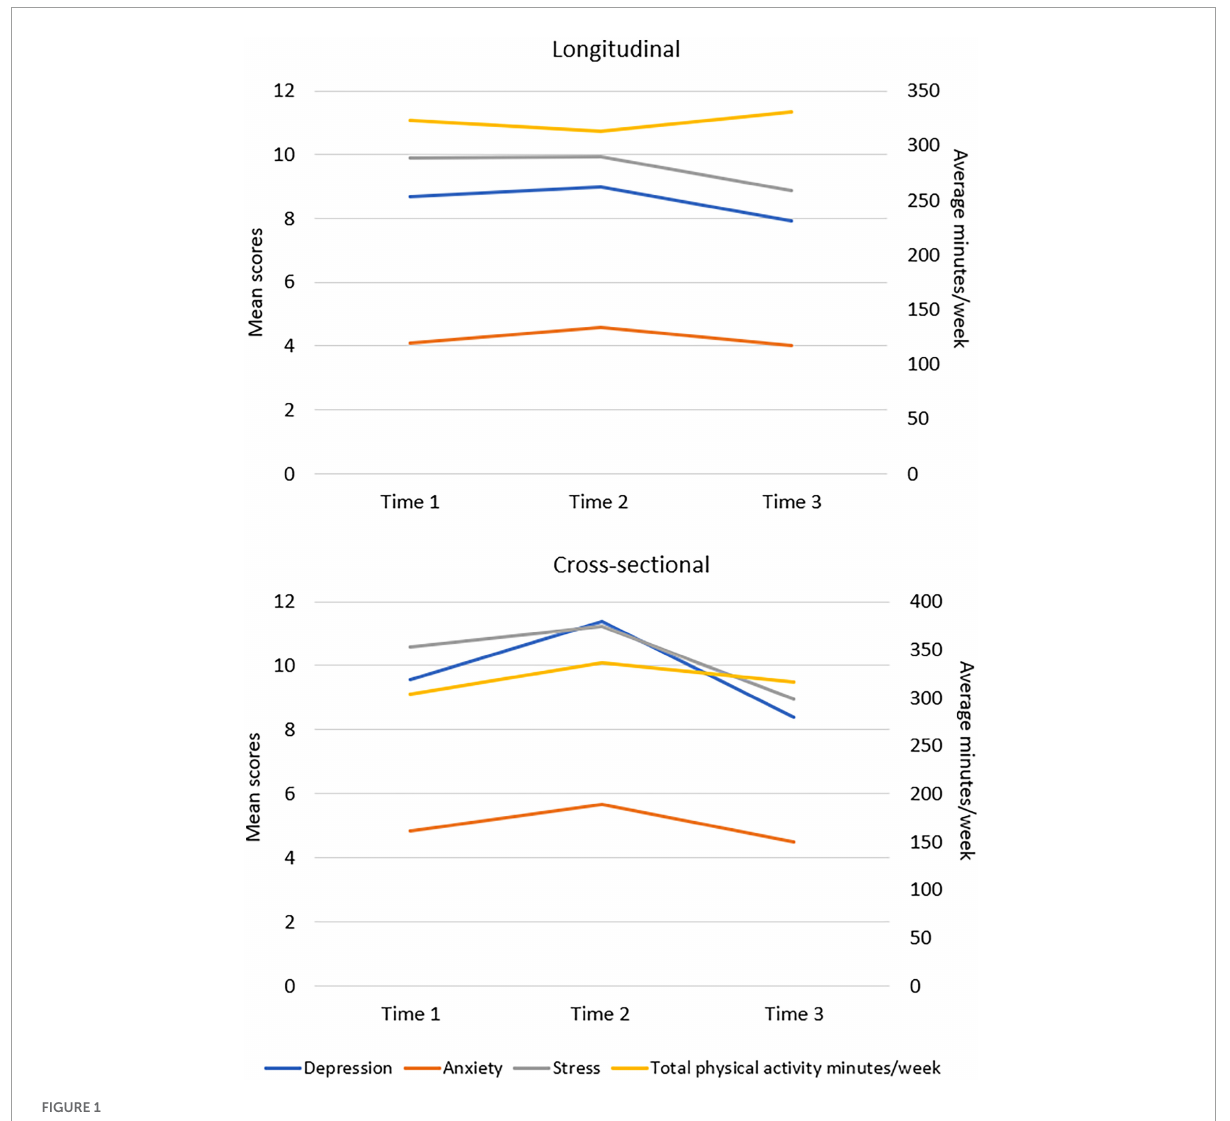
FIGURE1 Changes in depression, anxiety, stress, and physical activity over